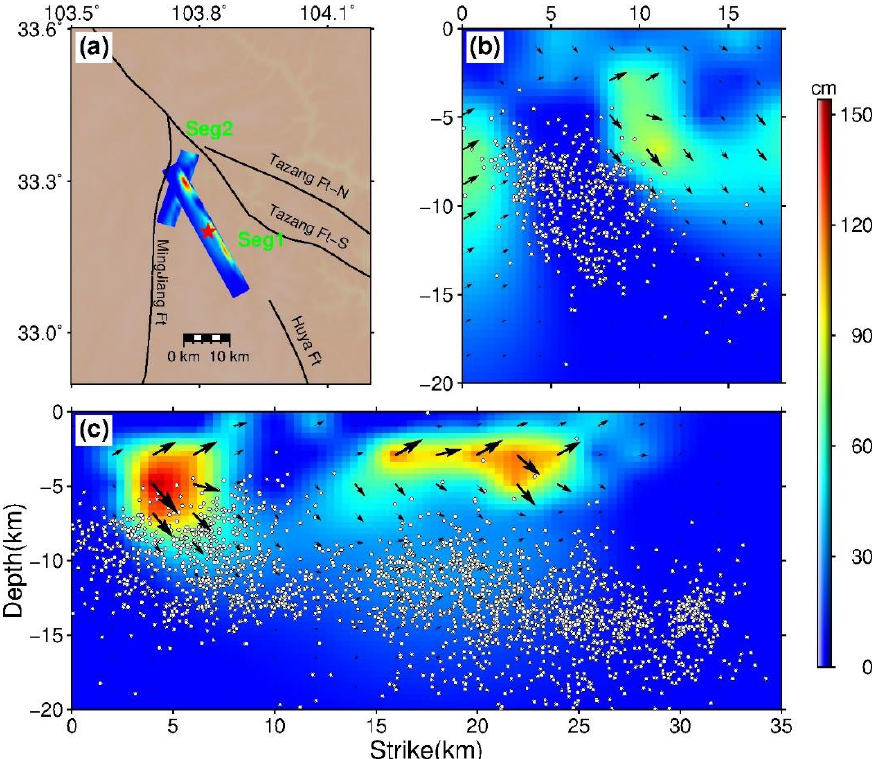
Figure 7. Slip distribution for our preferred model. ( a ) Projection of the slip model on the surface. Slip distribution of the ( b ) secondary fault, and ( c ) main fault. The white dots represent the relocated aftershocks. The slip distribution with arrows delineating the average rake of each sub-fault is color-coded. Other symbols are the same as Figure 1b.